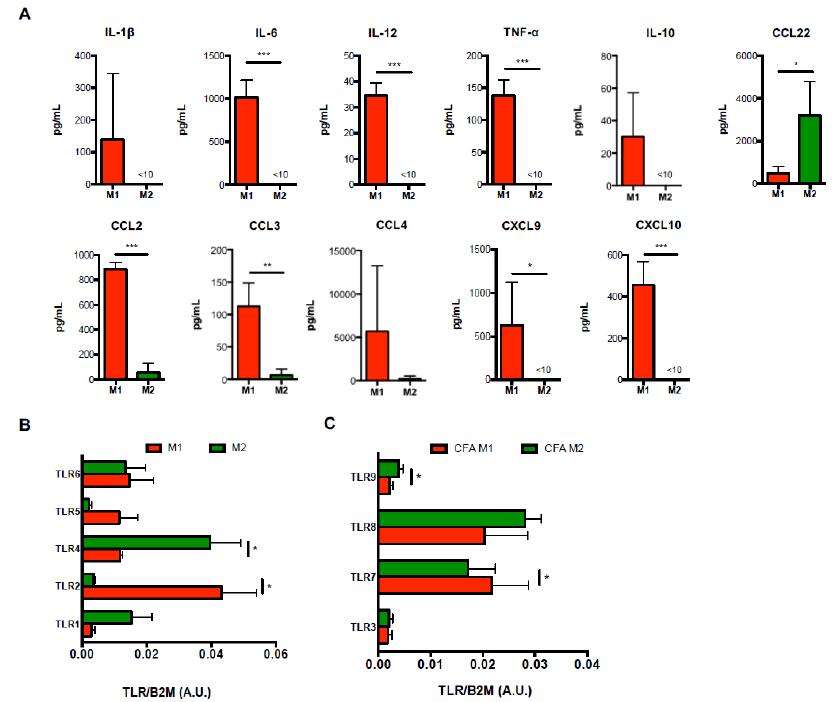
Figure 2. Expression of cytokines/chemokines and TLRs in M1 and M2 macrophages obtained from CFA mice. ( A ) ELISA of cytokines (IL-1 β , IL-6, IL-12, TNF- α , IL-10) and chemokines (CCL2, CCL3, CCL4, CCL22, CXCL9, and CXCL10) in supernatants of M1 or M2 macrophages. Data are reported as pg/mL and represent 10 independent experiments means ± SEM. * p < 0.05, ** p < 0.01, *** p < 0.001. ( B , C ) qRT-PCR analysis of the expression of both bacterial (TLR1, TLR2, TLR4, TLR5, TLR6) ( B ) and viral (TLR3, TLR7, TLR8, TLR9) ( C ) Toll-like receptors in M1 and M2 macrophages. Cycling threshold values are normalized to those of mRNA encoding β2 -microglobulin and data are normalized to the maximum value obtained for each donor. Data are expressed as arbitrary units (A.U.) and are shown as means ± SEM of eight independent experiments each in duplicate. * p < 0.05.